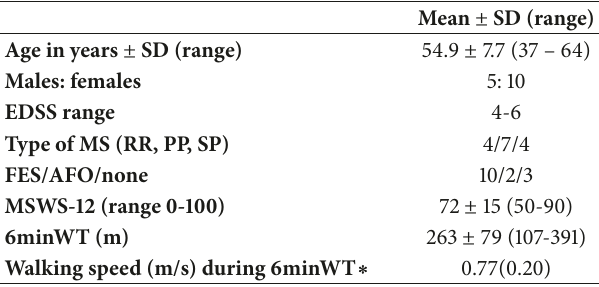
Table 1: Participant (n=15) characteristics, objective, and self- reported walking